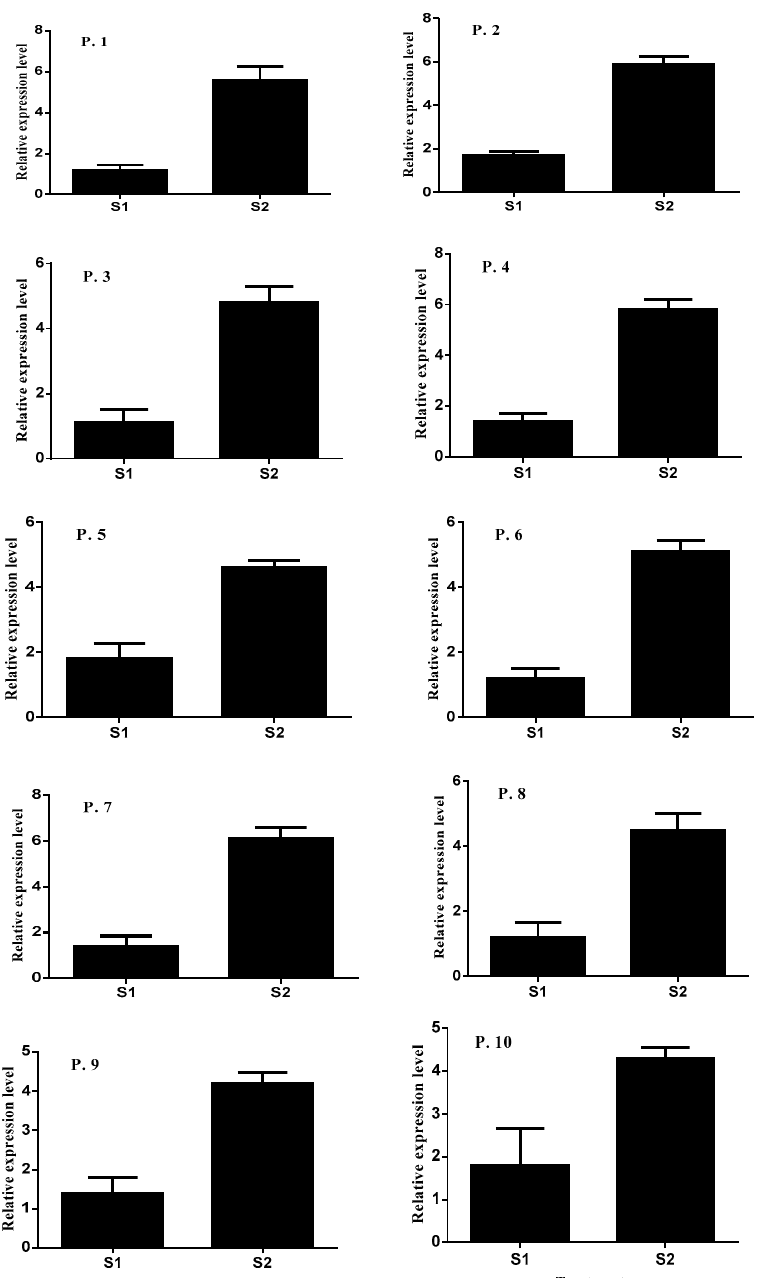
Figure 5. Relative expression levels of AeHKT1; 4 in in roots of Ae. tauschii populations under salinity conditions. Actin was used as an internal reference. Experiments were repeated three times. Values are means, and bars indicate standard deviation (SD). (S1 = 50 mM NaCl and S2 = 200 mM NaCl and P. = population).